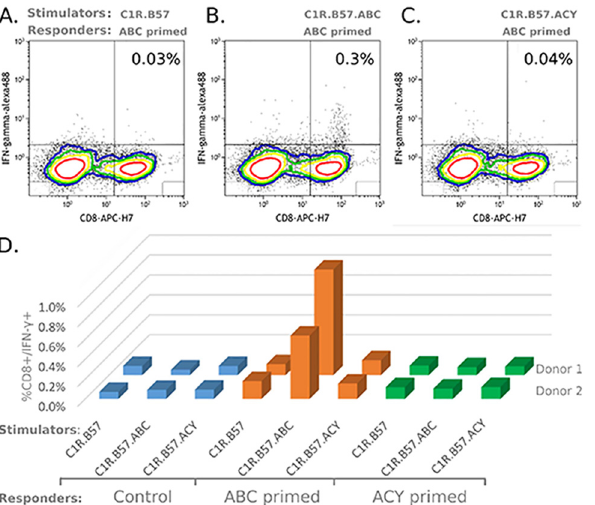
Fig 7. PBMC from a healthy HLA-B * 57:01 positive donor (Donor 1) where primed with abacavir at day 0, cultured for 14 days and then restimulated 1:10 with (A) HLA-B * 57:01 single antigen line (C1R.B57), (B) with O/N abacavir treated C1R.B57 (C1R.B57.ABC) or (C) with O/N acyclovir treated C1R.B57 (C1R. B57.ACY). Antigen activated cells were detected by ICS for IFN- γ production and CD8+/ IFN- γ